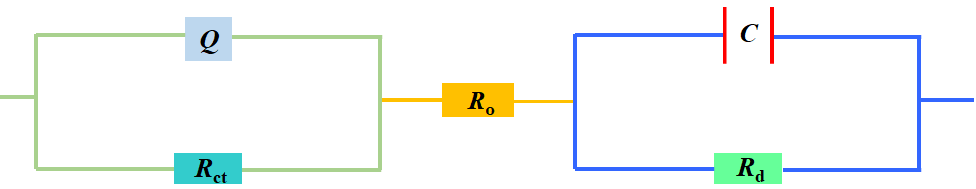
Figure 8. Equivalent electrical circuit for the electrochemical impedance spectra data simulation ( Q is the constant phase element and C stands for double ‐ layer capacitor). Table 2. Resistance distribution of the anode obtained from the equivalent electrical circuit. Figure 7. Nyquist plots of the anode under different influent concentrations.